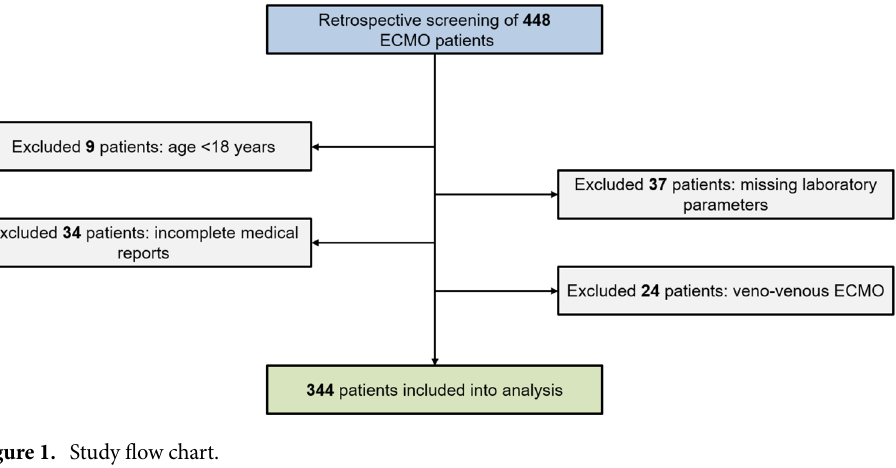
Figure 1. Study flow